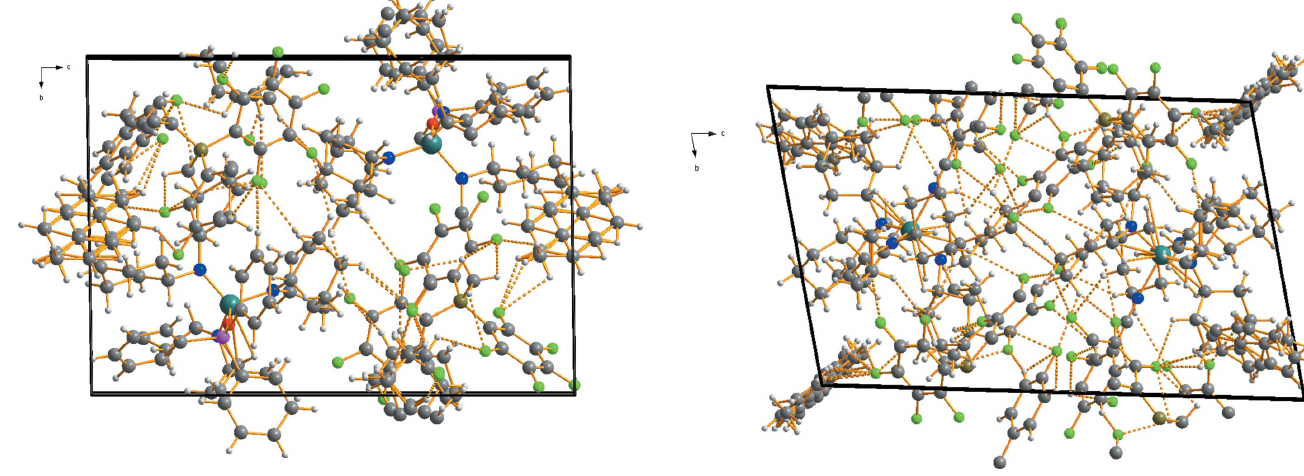
Figure 3 Aview along the a axis showing the packing of individual molecules in the crystal of ( 1 ), with C—H (cid:2)(cid:2)(cid:2)(cid:2) F bonds shown as dashed lines. Both components of the disorder are shown. Colour code: C dark grey, H light grey, N blue, Ti teal, B dark yellow, F bright green, P purple, O red.